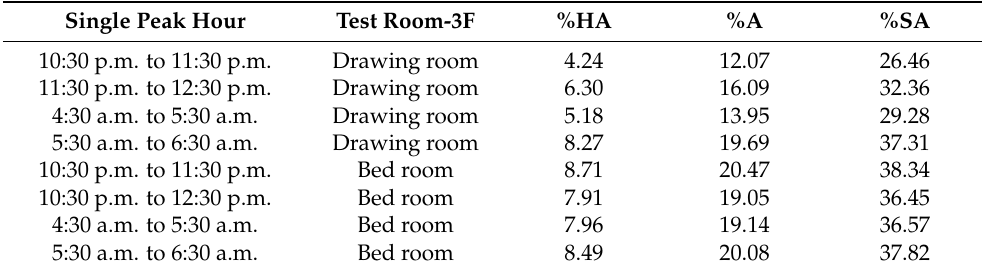
Table 8. Vibration annoyance rate of the third-floor test room during peak hours of train operation. Single Peak Hour Test Room-3F